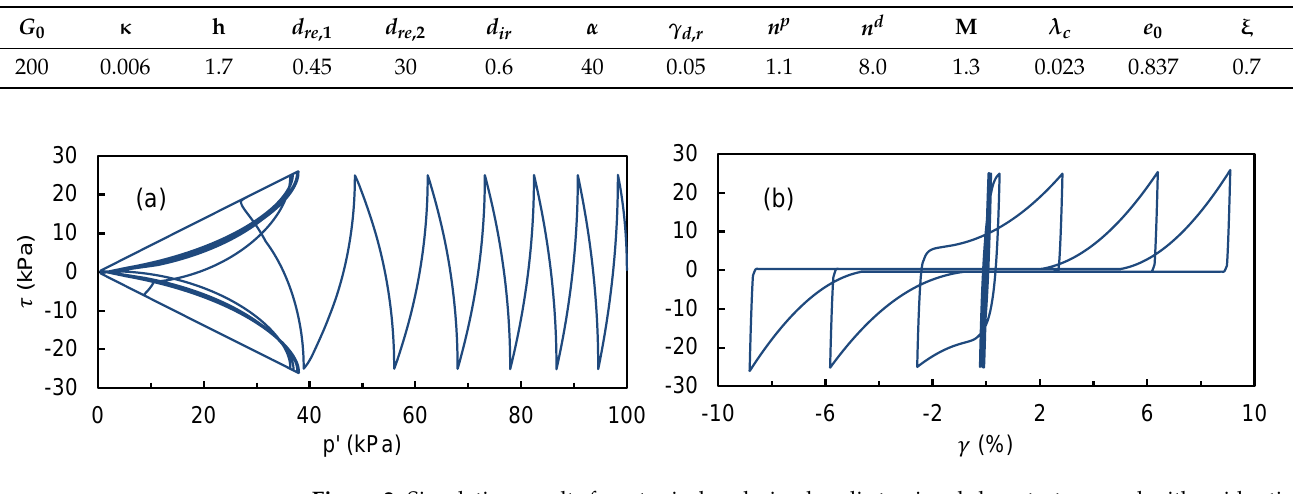
Figure 2. Simulation results for a typical undrained cyclic torsional shear test on sand with void ratio of 0.65: ( a ) effective stress path; ( b ) stress–strain relationship.